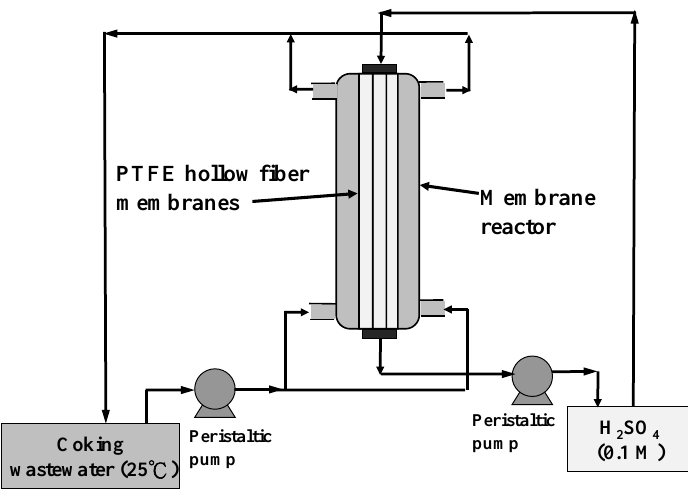
Figure 2. Schematic of the HFMC apparatus used at the 1st stage ammonia removal.